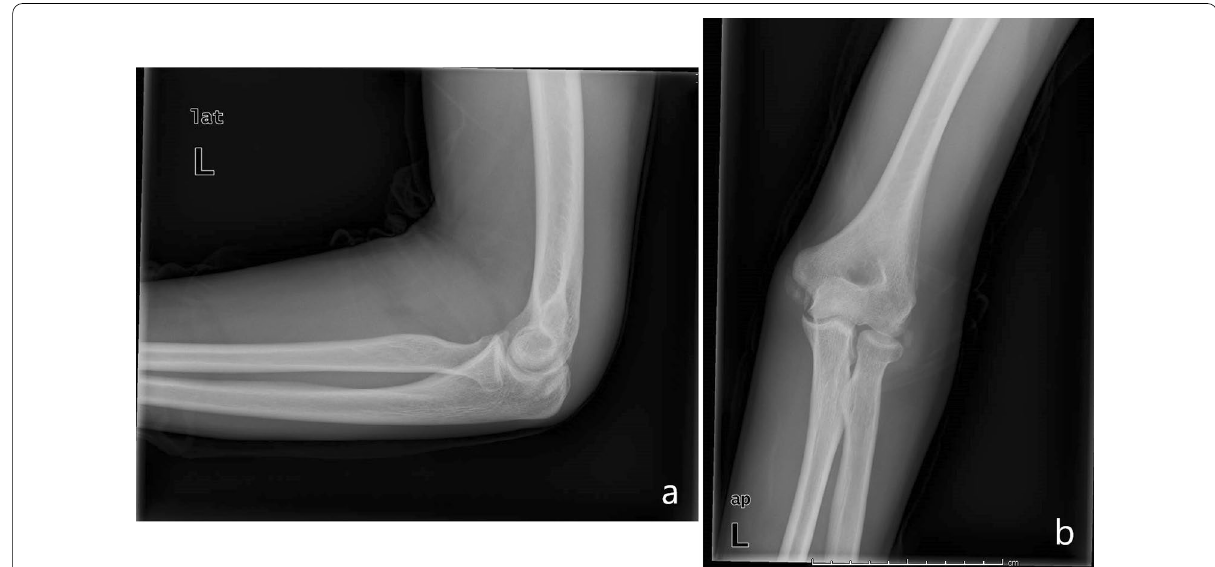
Fig. 5 Heterotopic ossifications on X-ray examination. X-ray examination with heterotopic ossifications findings around both lateral and medial condyles ( a , b